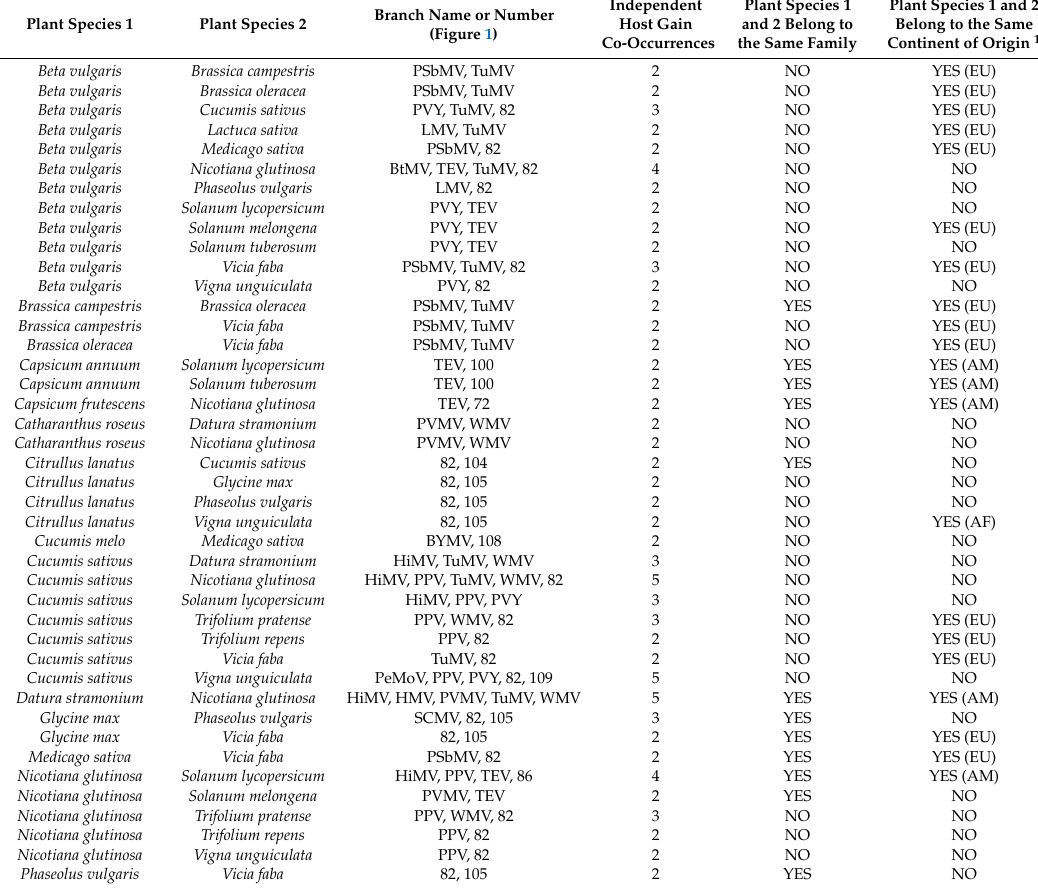
Table 3. Host gain co-occurrence (i.e., host gains inferred on the same branch of the potyvirus tree) found repeatedly (i.e., on at least two di ff erent branches for a given pair of plant species). Plant Species